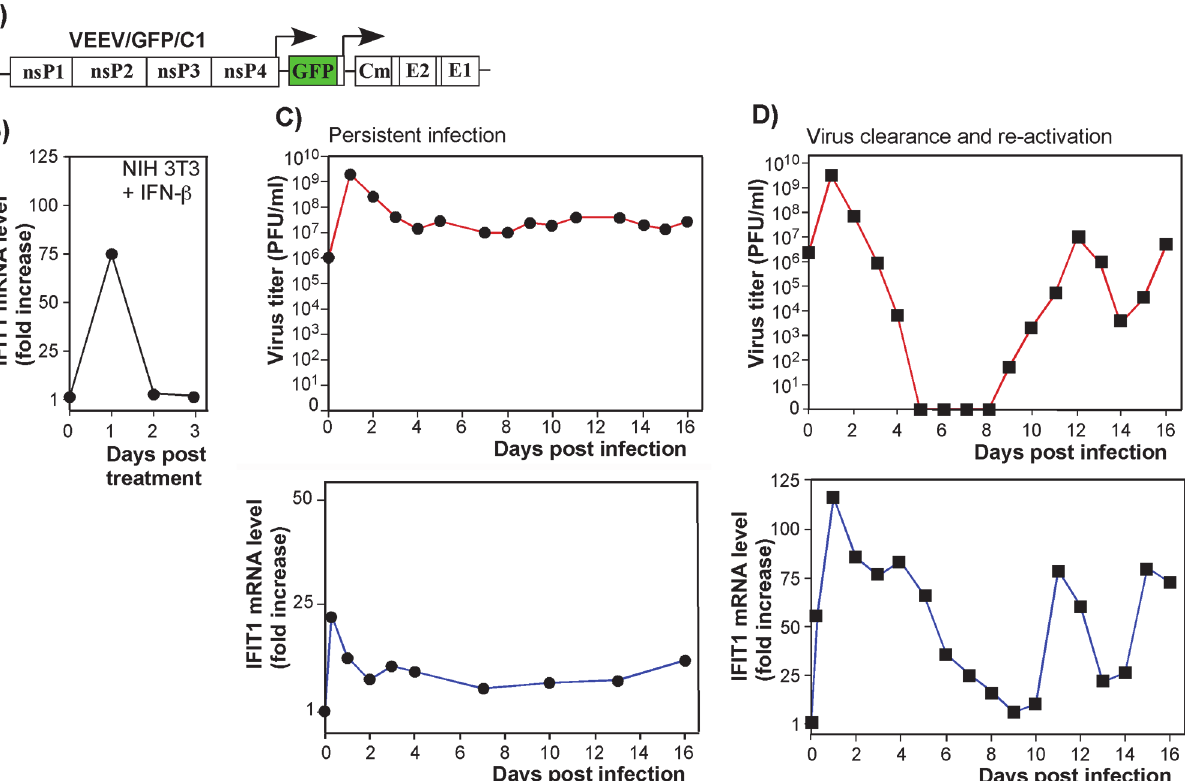
Fig 6. IFIT1 is expressed via IFN-dependent and alphavirus replication-dependent pathways. (A) The schematic representation of VEEV TC-83-based recombinant virus genome (VEEV/GFP/C1) containing mutations in the capsid-specific NLS. (B) The profile of IFIT1 induction in the NIH 3T3 cells treated for 24 h with IFN- β (500 IU/ml) and then incubated in IFN-free media. (C) IFN- α / β R -/- MEFs were infected with VEEV/GFP/C1 at an MOI of 20 PFU/cell. Media were replaced at the indicated time points, and cells were harvested for RNA isolation and analysis. Panels represent titers of the virus and IFIT1 mRNA accumulation profiles. (D) NIH 3T3 cells were infected with VEEV/GFP/C1 at an MOI of 20 PFU/cell. As in the experiment presented in panel (C), media were replaced at the indicated times post infection, and RNAs were isolated from the cells. Panels represent titers of the virus and IFIT1 mRNA accumulation profiles. Two independent RNA samples were prepared for each time point for VEEV/GFP/C1-infected cells and three RNA samples for IFN- β -treated cells.